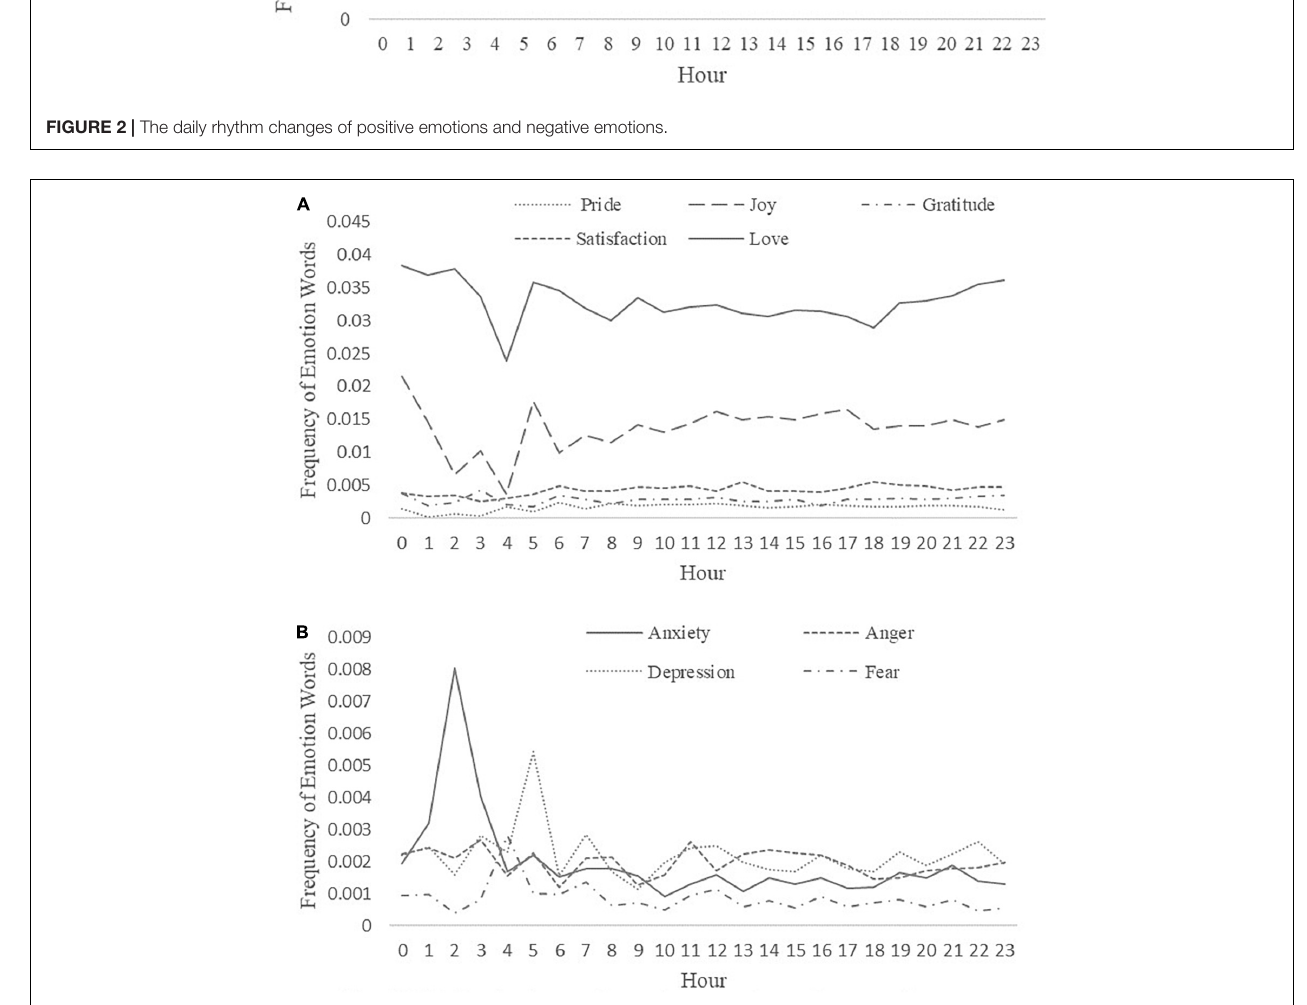
FIGURE 3 | (A) Daily rhythms of positive emotion subcategories in TTs. (B) Daily rhythms of negative emotion subcategories in